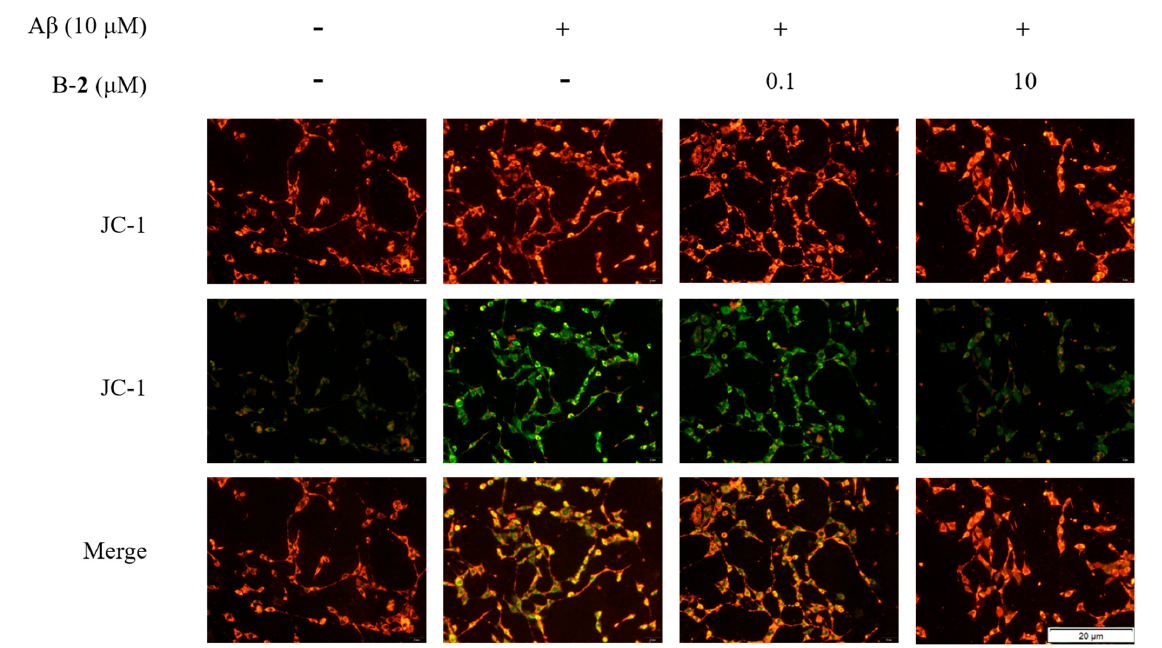
Figure 6. Mitochondrial membrane potential of HT − 22 cell treated by benzaldehydes 2 . Data are expressed as the means ± SD ( n = 3).